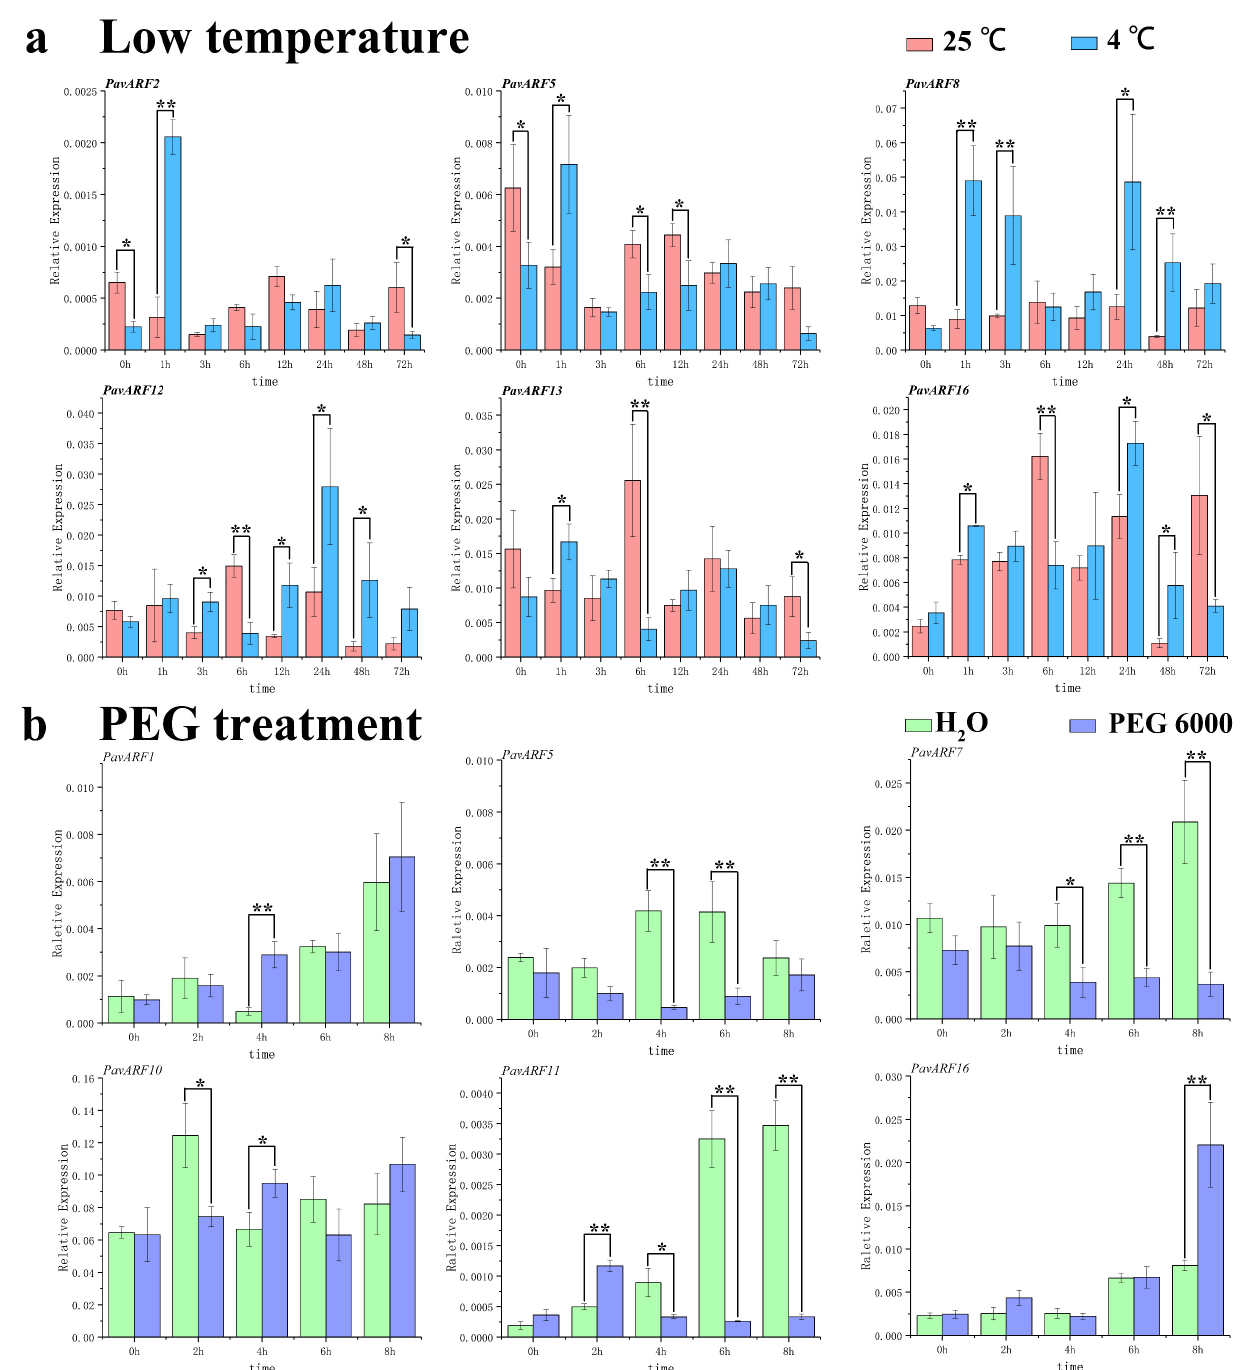
Figure 7. Expression profiling of PavARF at the low-temperature stress ( a ) and drought ( b ). * represents p < 0.05 in the variance analysis and ** represents p < 0.01 in the variance analysis.